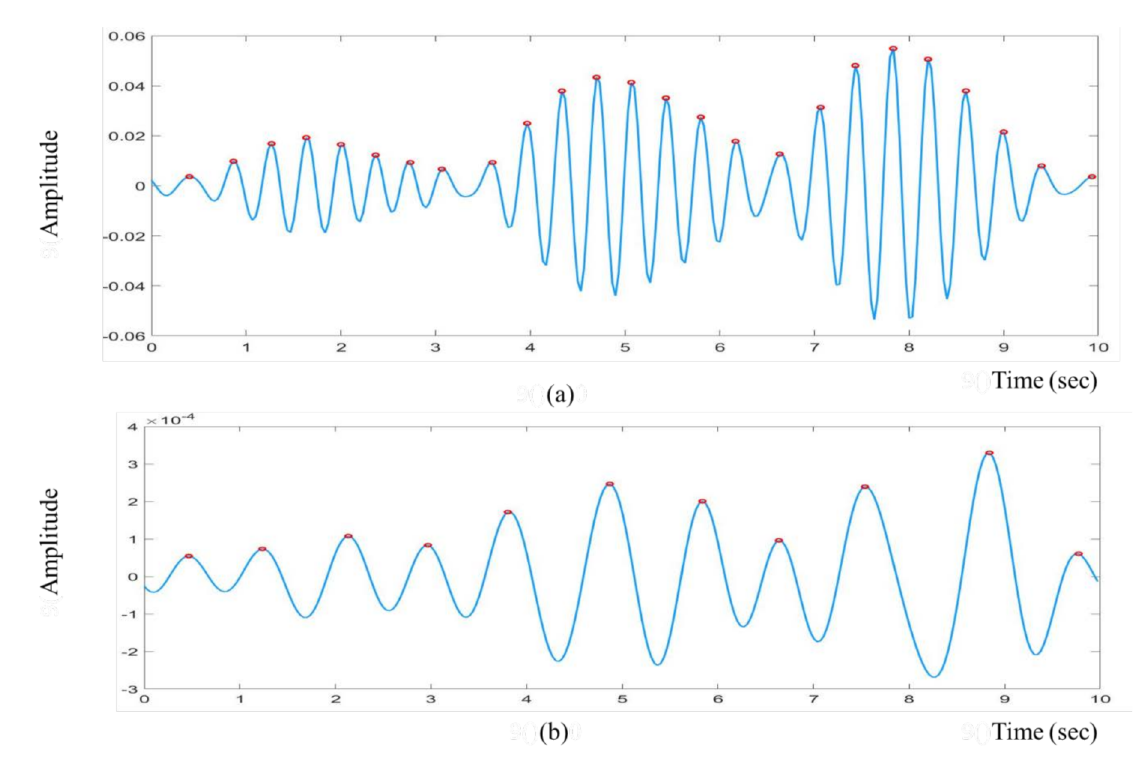
Figure 10. The filtered cardiorespiratory signals are shown in the figure. The red colour markers indicate the peak locations of the filtered signal. ( a ) Filtered cardiac signal, ( b ) filtered respiratory